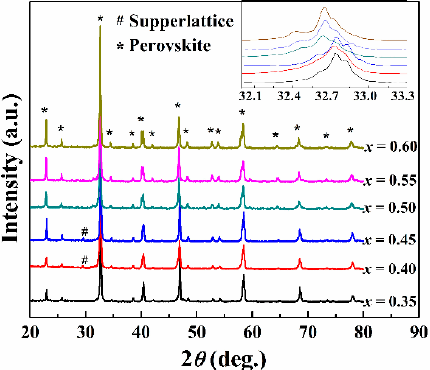
Figure 3. XRD patterns of the (1– x )CLT- x NMT ceramics.